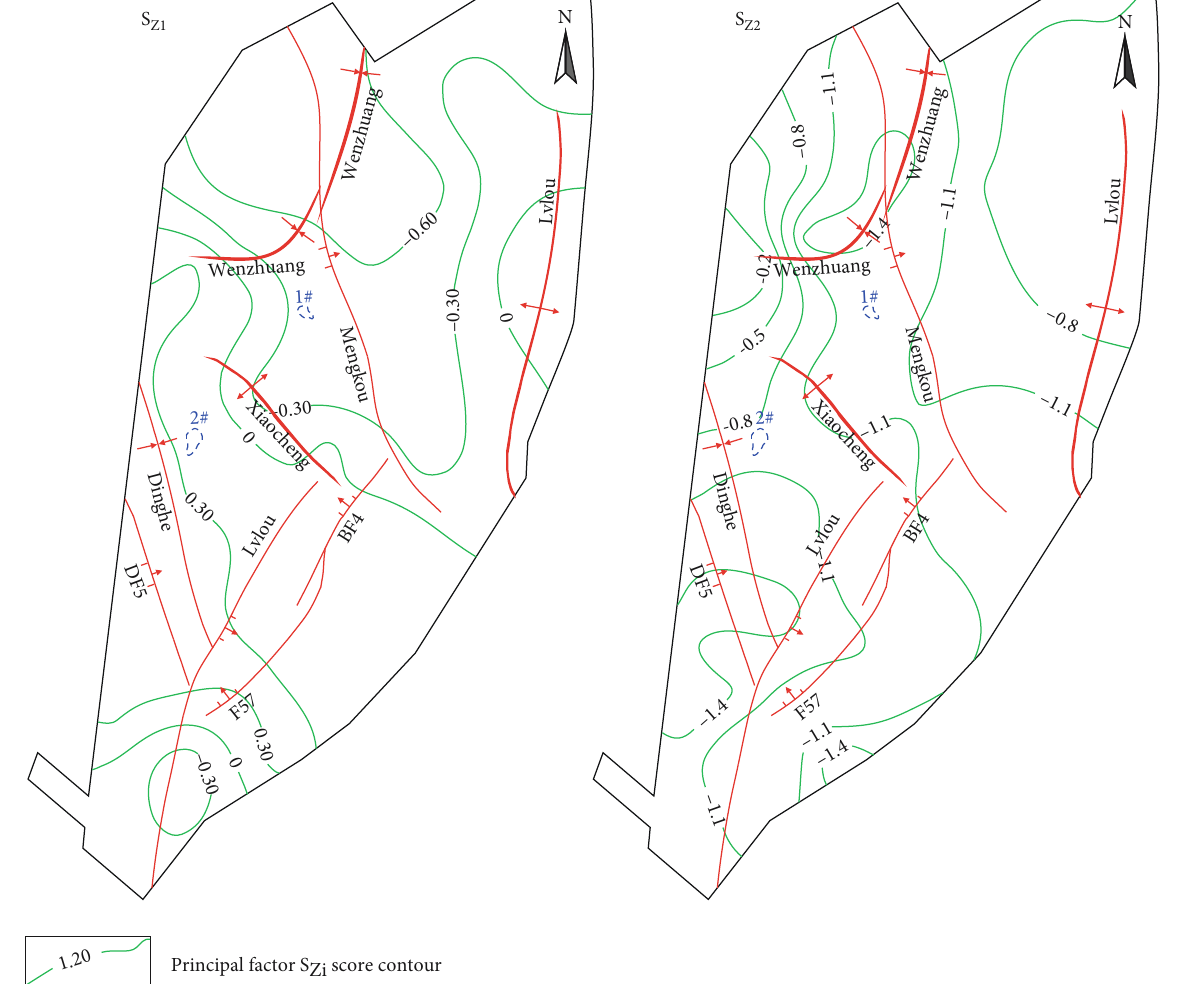
S Z 1 , Z 2 for Carboniferous